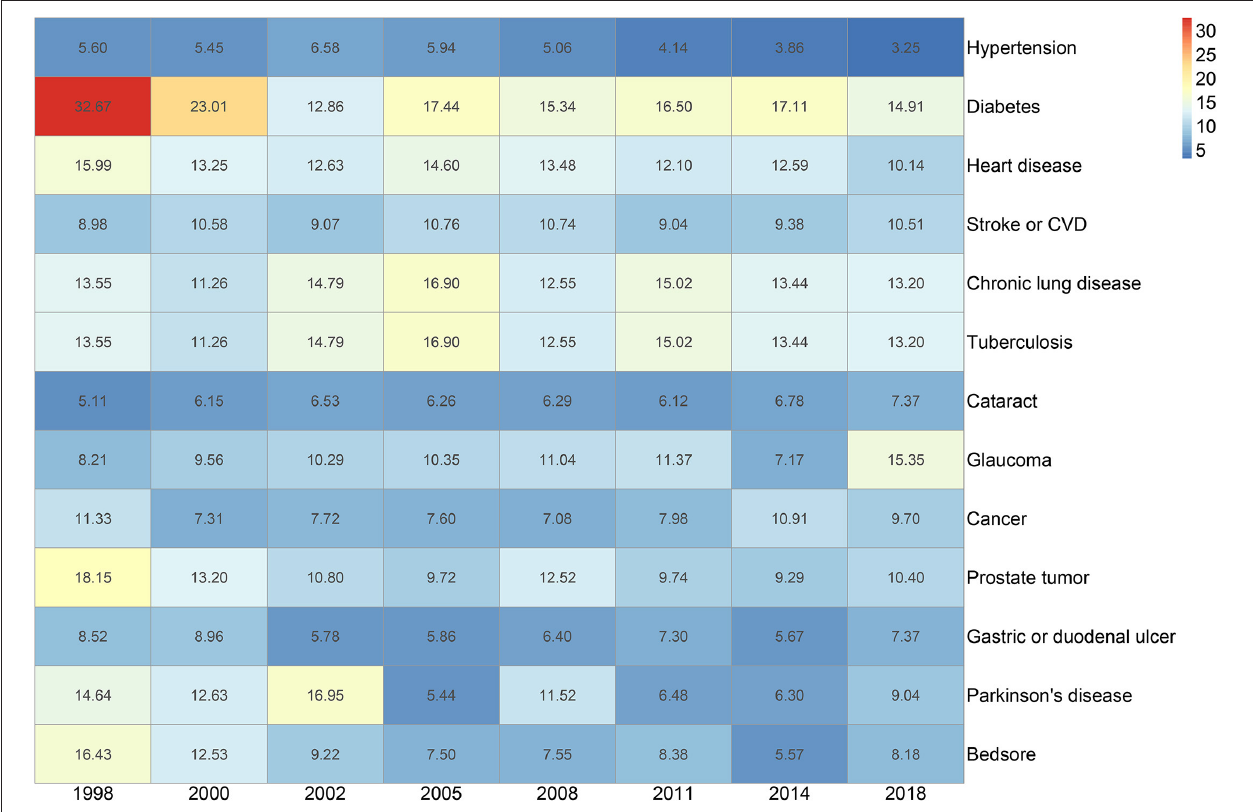
FIGURE 4 | Heatmap of relative risk (RR) of singular chronic disease or condition by the survey of eight waves.